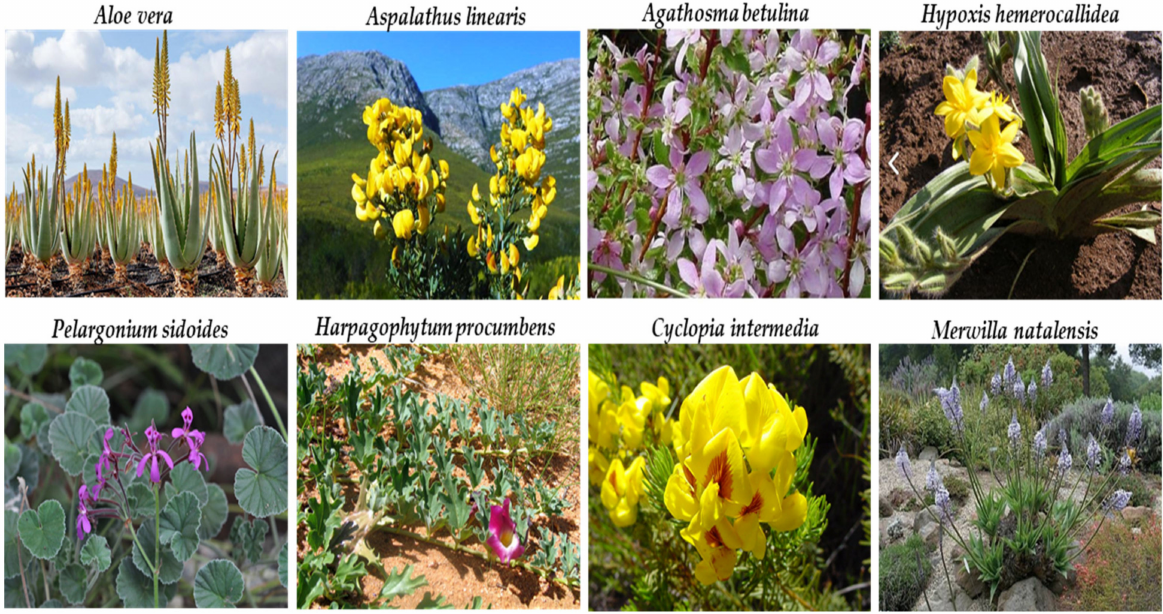
Figure 3. Catalogue of some of the indigenous plants found in the Cape Floristic Region of South